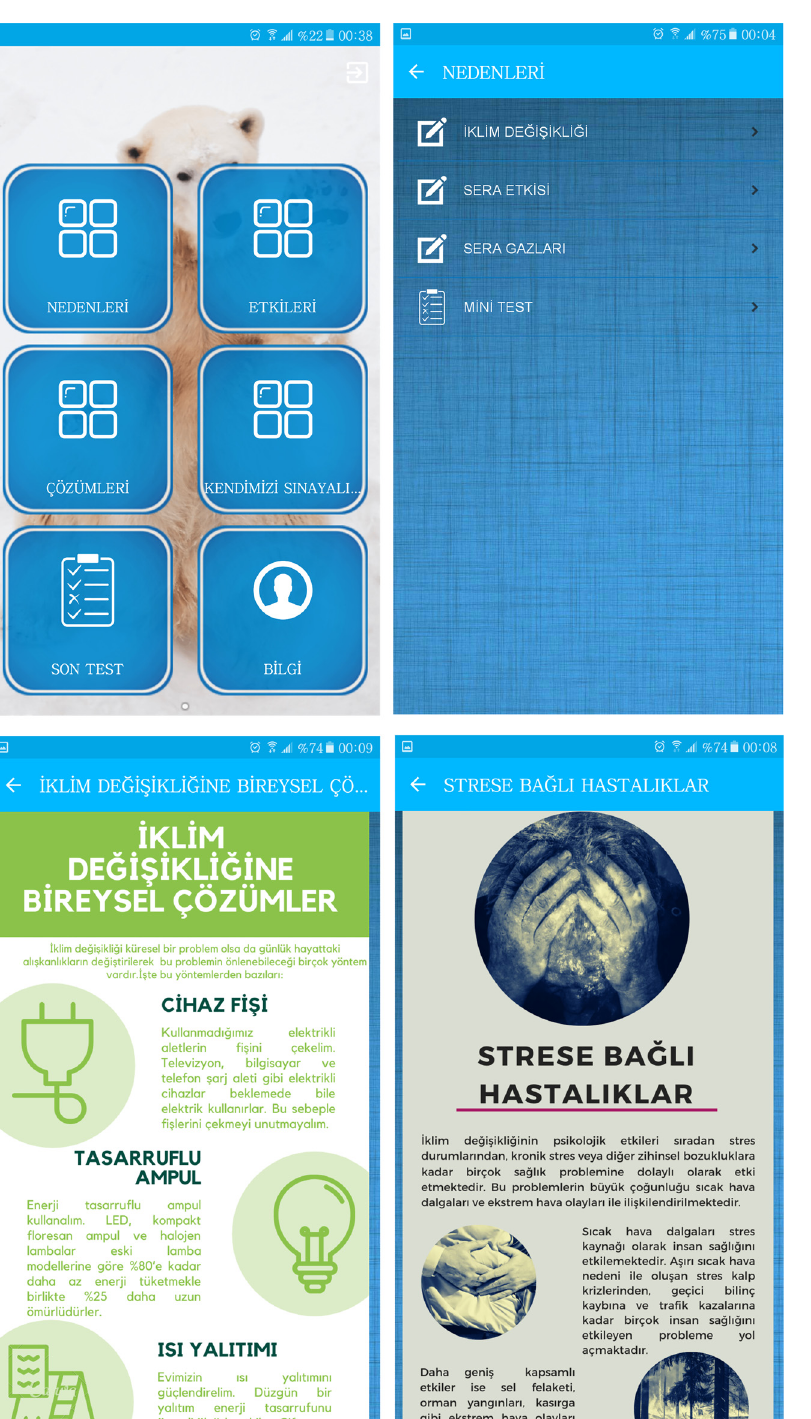
Figure 2: Mobile phone screenshots with the Andorid ® operating system of the MA. The screenshots present infographics for successful learning using Item selection based on expert opinions finalized selection by taking, subject content, item difficulty index and item distinctiveness into consideration. Eight items, with distinctiveness of >0.30, (1, 2, 15,